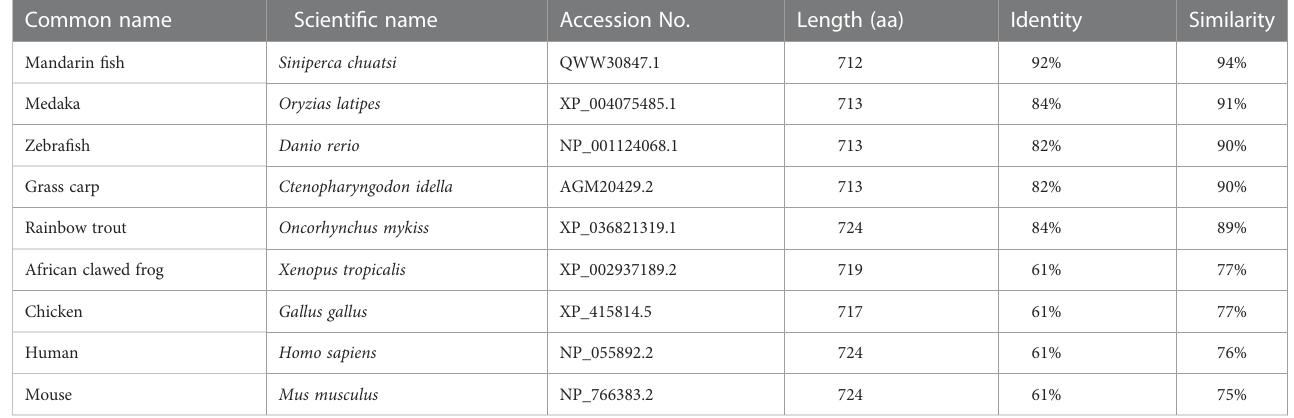
TABLE 2 Amino acid identity and similarity among Lc- SARM and SARM from other